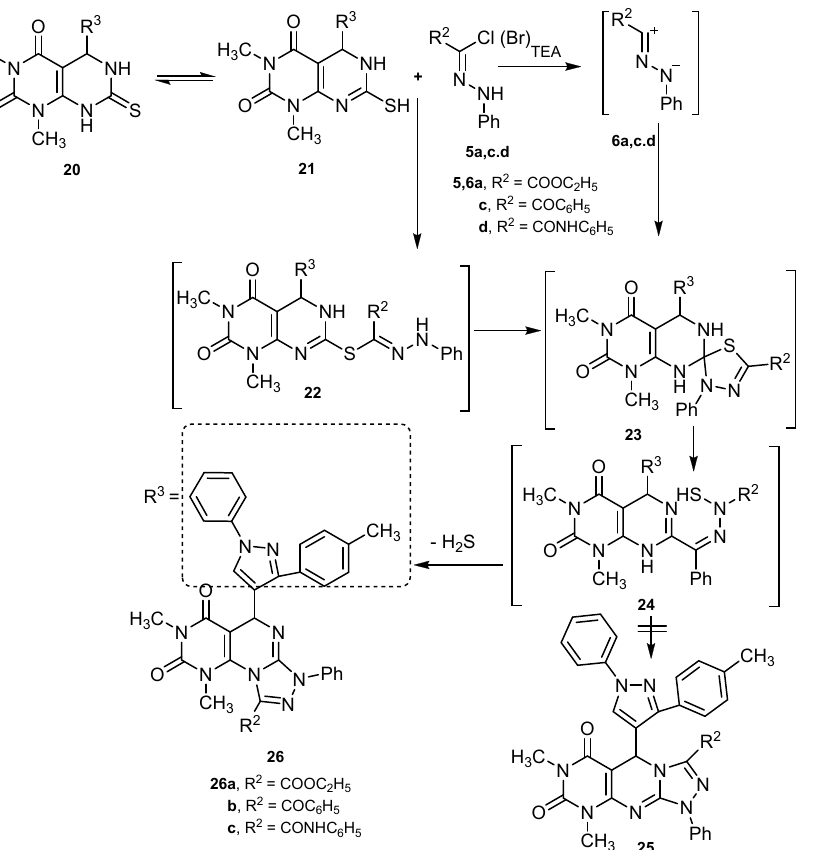
Scheme 7. Synthesis of 1,3-dimethyl-7-phenyl-5-(1-phenyl-3-( p -tolyl)-1 H -pyrazol-4-yl)-9-substituted 5,7-dihydropyrimido[5,4- e ][1,2,4]triazolo[4,3- a ]pyrimidine-2,4(1 H ,3 H )-dione 26a – c.